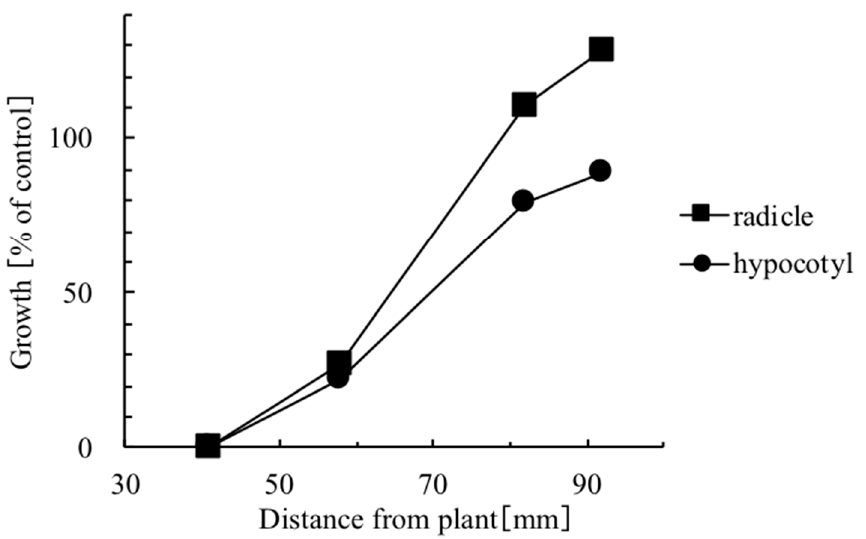
Figure 3. Effect of leaf volatiles from star anise on radicle and hypocotyl growth [%] of lettuce seedlings as a function of distance from plant material using the Dish Pack method. as a function of distance from plant material using the Dish Pack